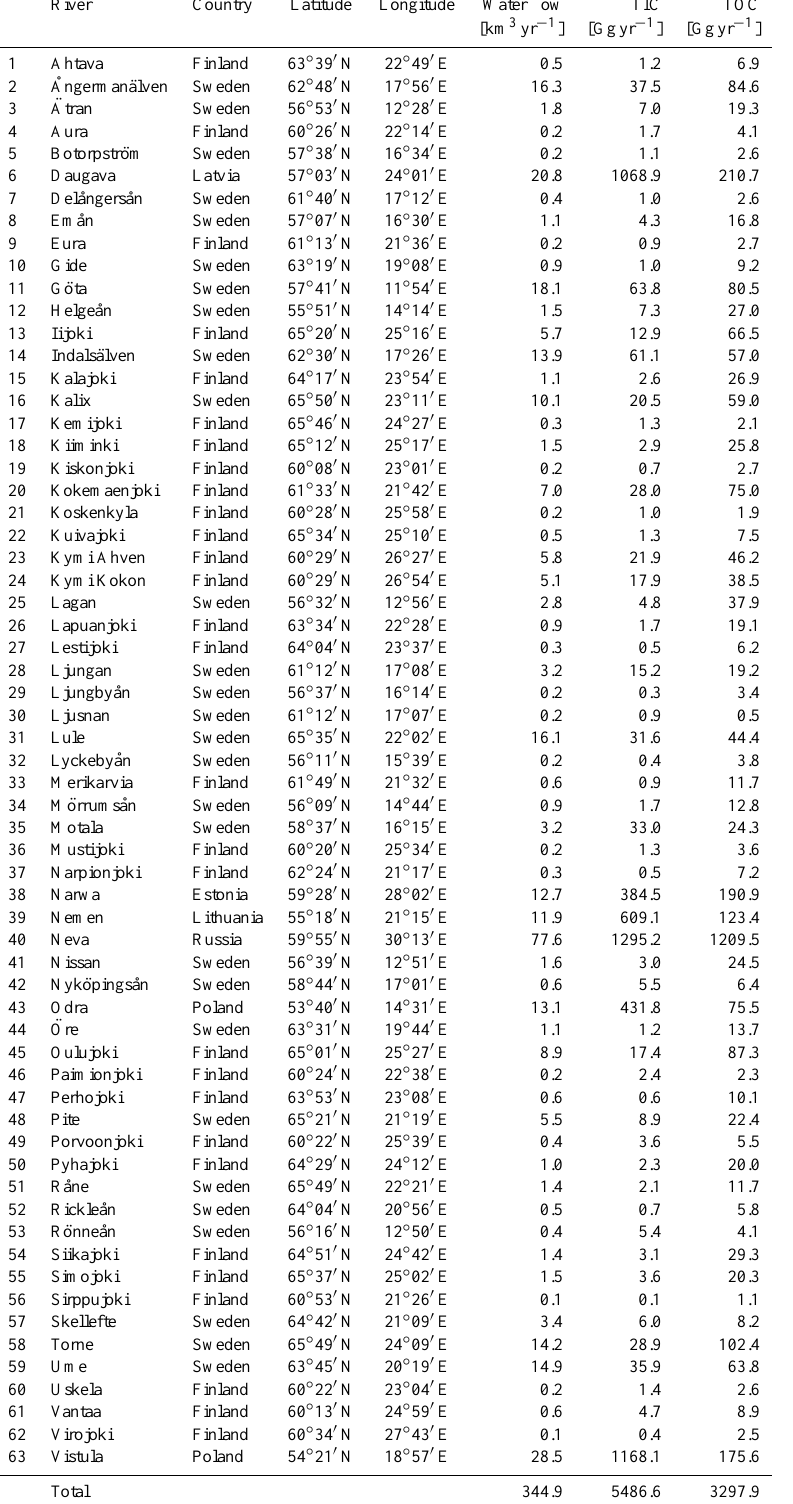
Table 1. Water flows, TIC and TOC loads for the 63 largest rivers entering the Baltic Sea. Carbon fluxes are expressed in Ggyr − 1 (Gg=10 9